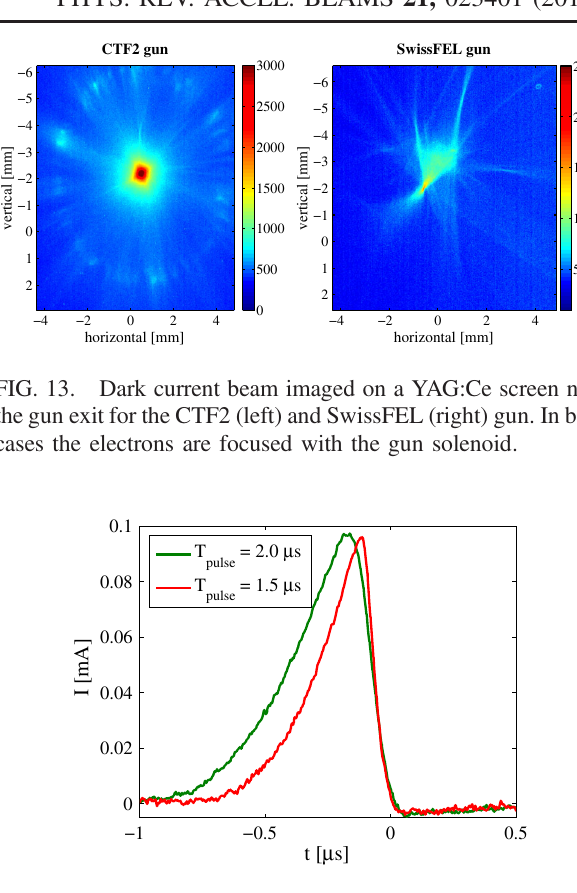
FIG. 14. Dark current measured by the ICT at 2 μ s and 1 . 5 μ s gun rf pulse lengths.